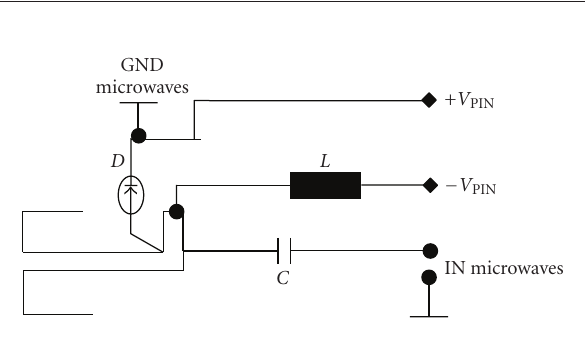
Figure 8: PIN diode antenna diagram. D is the PIN diode, L = 0 . 2mH, and C = 40pF.